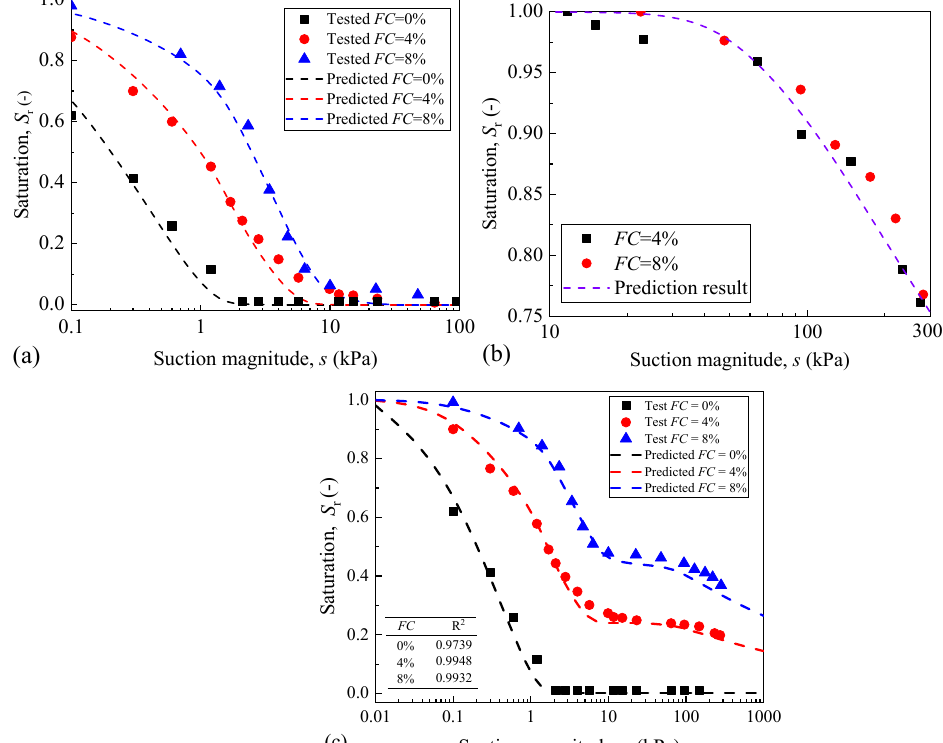
Figure 6. The tested and predicted data for ( a ) the SWRCs of inter-aggregate pores and ( b ) the SWRCs of intra-aggregate pores; ( c ) FC = 4% and 8%.